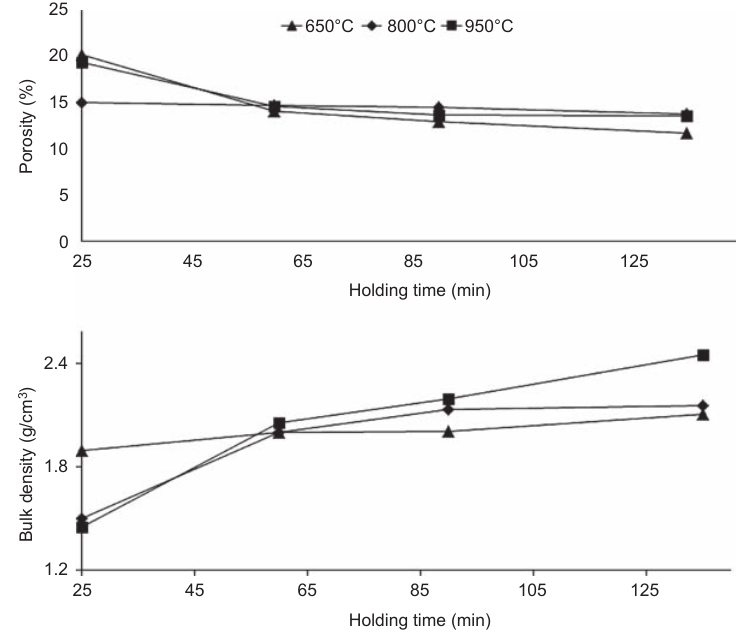
Figure 8 The variation of the (A) porosity and (B) bulk density vs. different holding times at different temperatures.